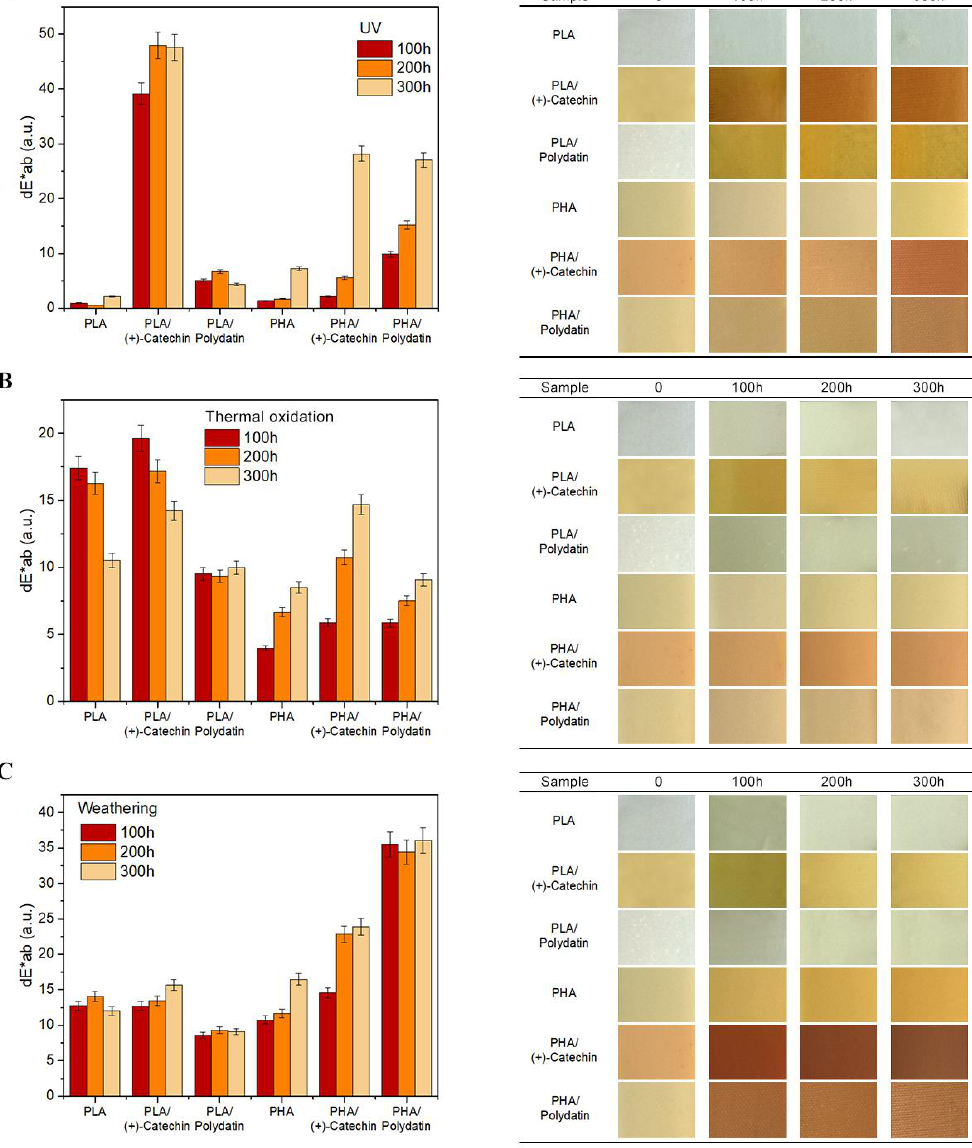
Figure 9. Change of color of PLA and PHA samples after UV exposure ( A ), thermal oxidation ( B ), and weathering ( C ) aging.